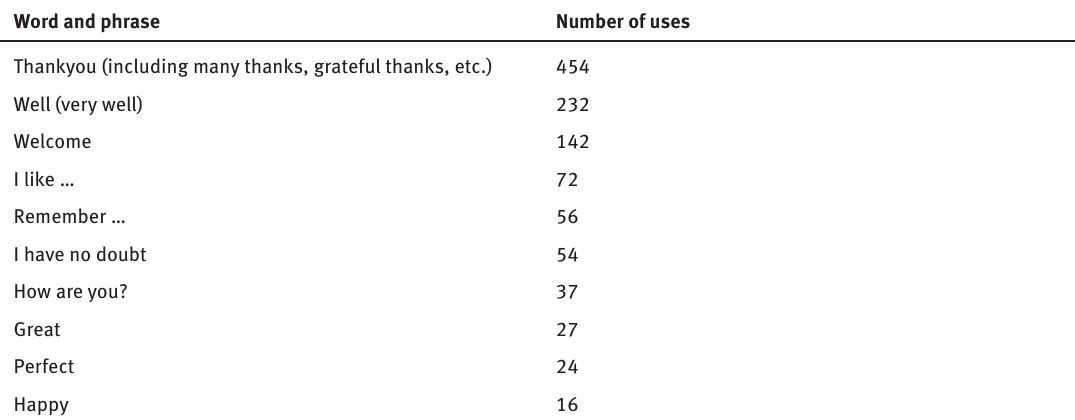
Table 4: The most common words in the forum messages in Open Doors I Word and phrase Number of